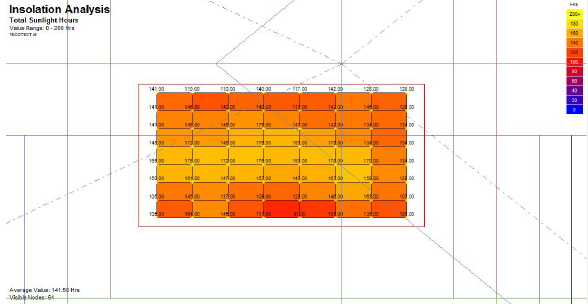
Figure 9: Annual total sunlight hours at west